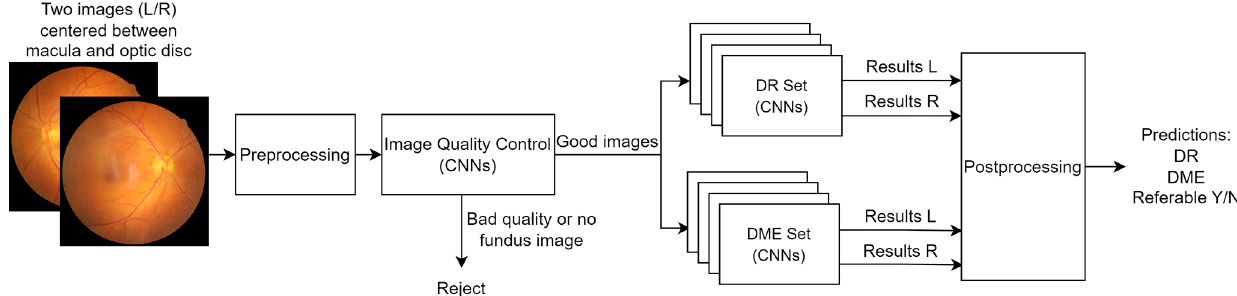
Figure 1. Graphical representation of the MONA.health diabetic eye screening software. A fundus image of each eye is preprocessed, after which an image quality control is executed. The images of sufficient quality are the input to an ensemble of DR models and an ensemble of DME models. L/R: fundus image of the left/right